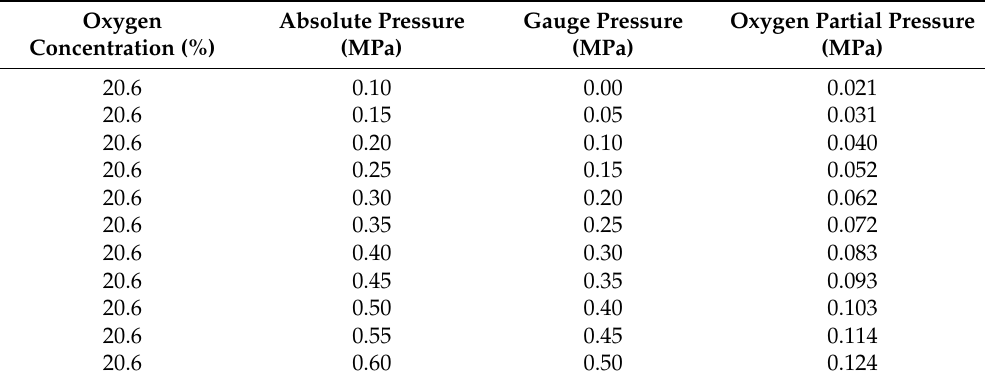
Table 1. Relationship between absolute pressure, the gauge pressure of the device, and oxygen partial